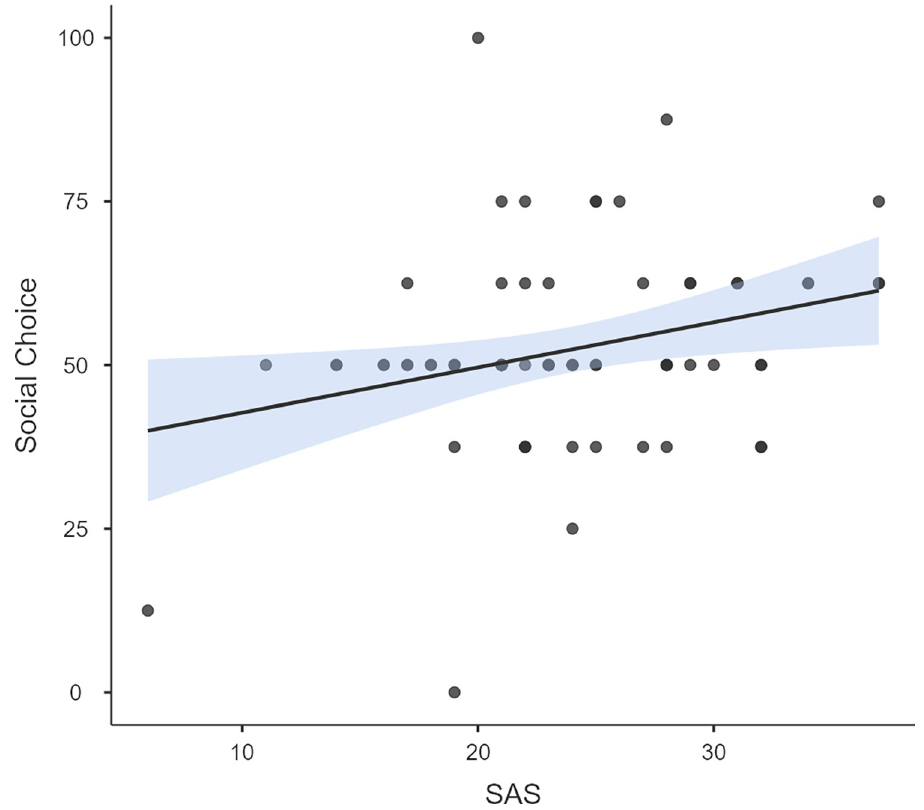
Fig 4. Scatter graph for social skills as measured on SAS and the preference for social stimuli as measured on button task (for participants above age 5 years).